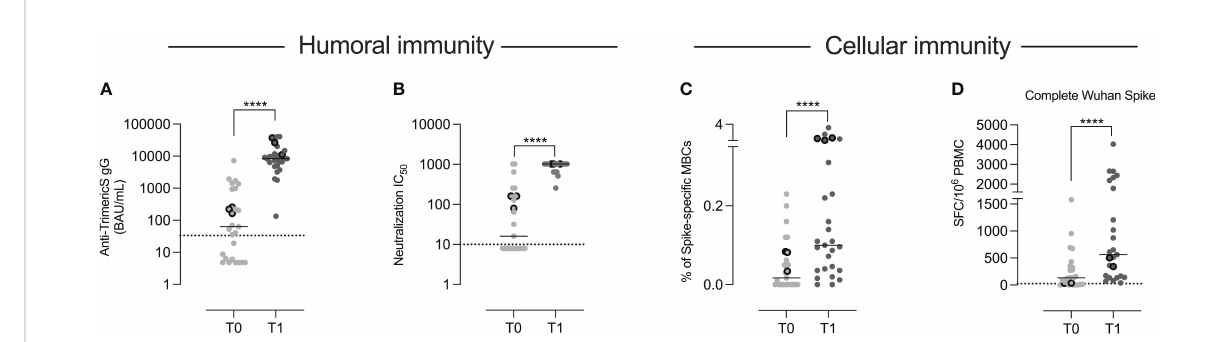
FIGURE 2 Humoral and cellular immunity. In the 27 children included in the study, we measured the concentration of anti-TrimericS IgG (BAU/mL) before (T0) and 10 days after the 2nd vaccine dose (T1) (A) . (B) The titer of neutralizing antibodies against the Wuhan virus (IC50) is shown. The frequency of memory B cells speci fi c for the Wuhan spike protein is reported in (C) . In (D) we show the number of T cells (expressed as numbers of spot-forming cells (SFC)/10 6 PBMC) that produced IFN gamma against the complete Wuhan spike protein. The three children that had experienced COVID-19 before vaccination are indicated by the dots with thick borders. Dashed lines indicate the cut-off value for each test. Bars indicate medians. A non-parametric Wilcoxon matched pair signed-rank test was used to evaluate statistical signi fi cance between T0 and T1. Two-tailed P value signi fi cances are shown as ****p <